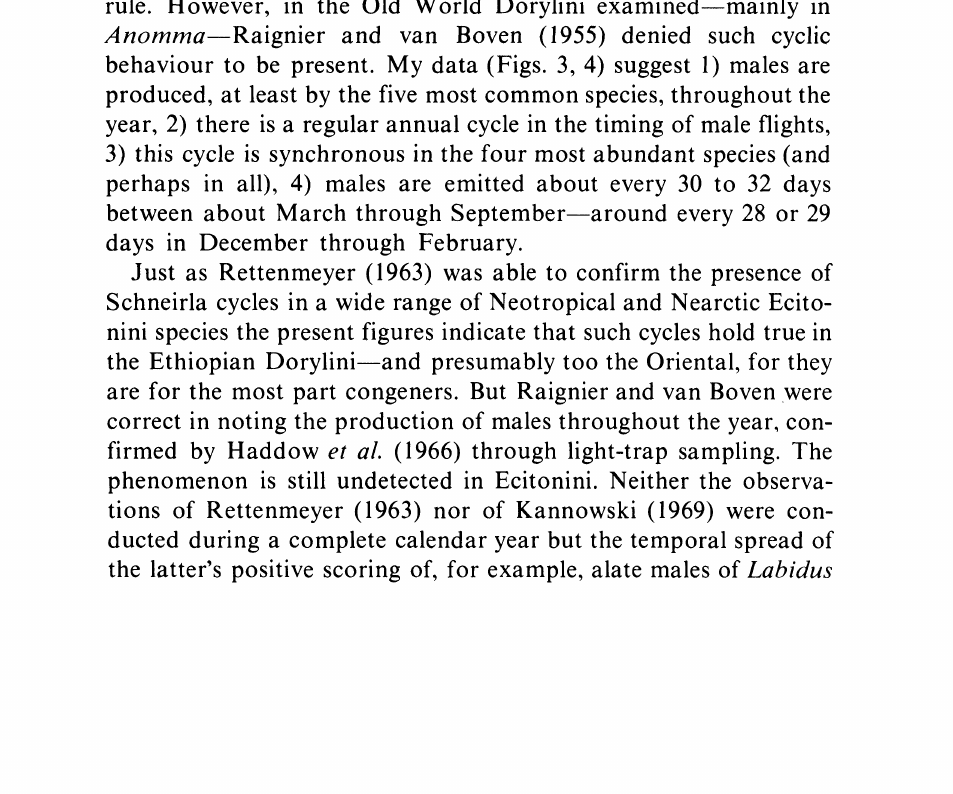
Fig. 6. Daily frequencies of the two most abundant species in the Legon trap samples, with days of missing samples